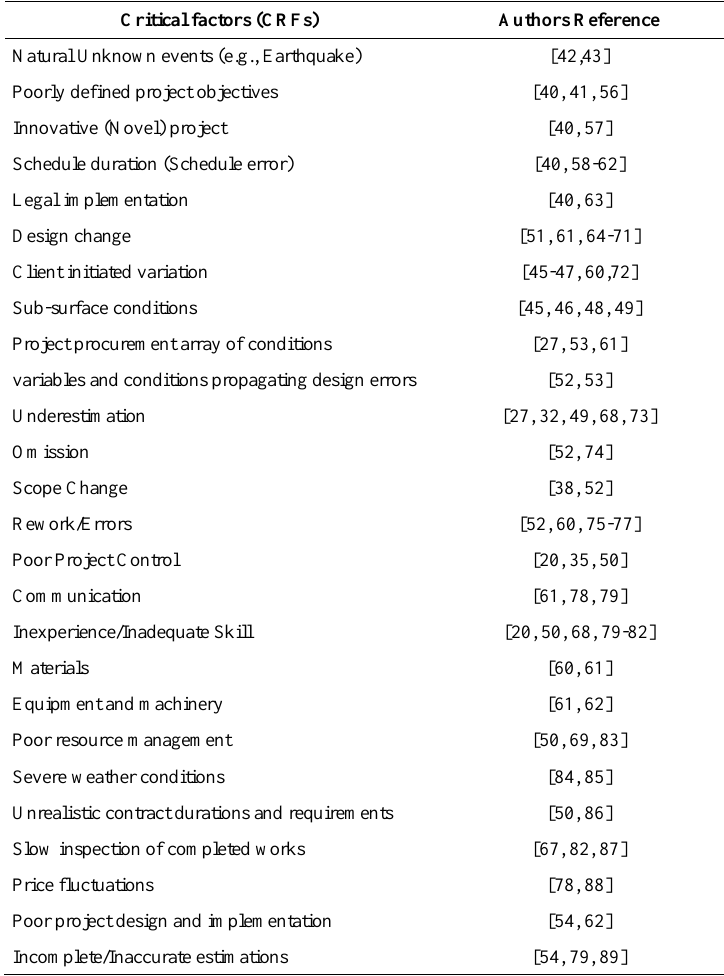
Table 1. Technical causes/factors of cost